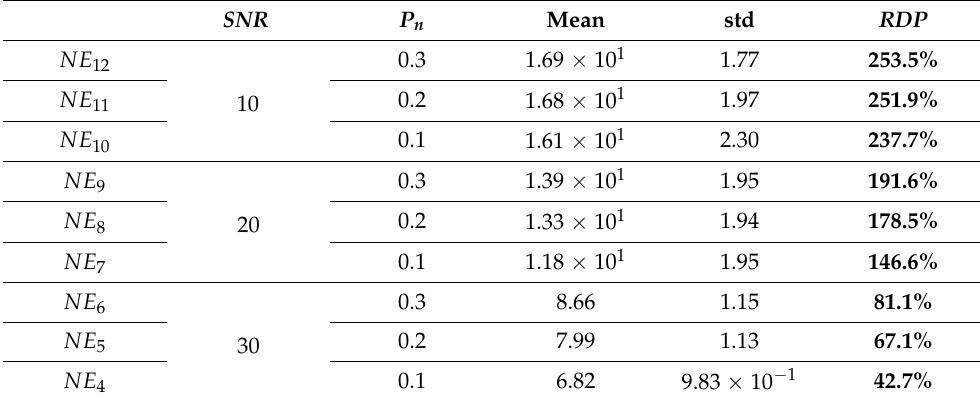
Figure 2. Average relative deterioration percent among all algorithms in all benchmarks of different NES. Table 2. Experimental results of DDEA-SE on 30-dimensional Ackley problems.